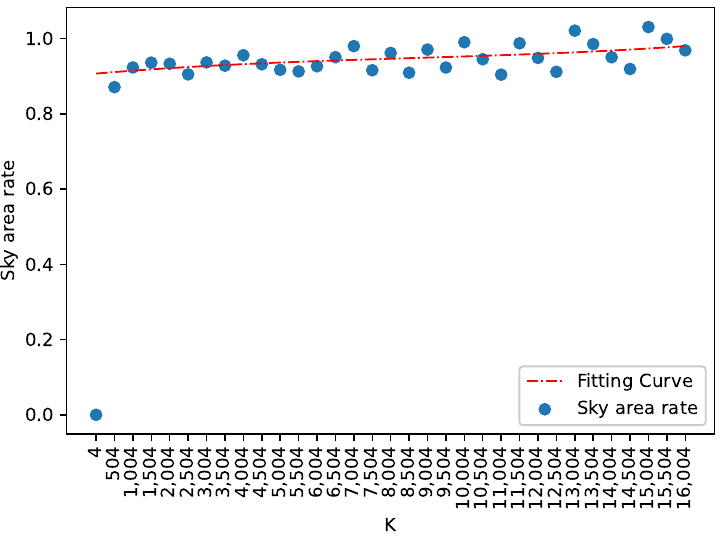
Figure 8. The sky occupancy statistics of different K ; the red curve is the fitting